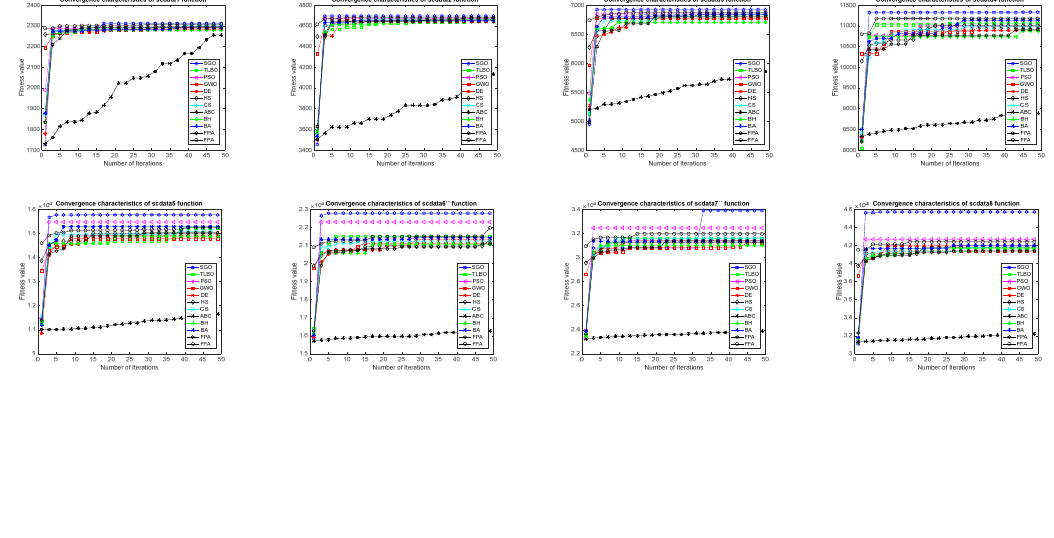
Fig. 4. Convergence characteristics of weakly correlated 0-1 KPs on first 50